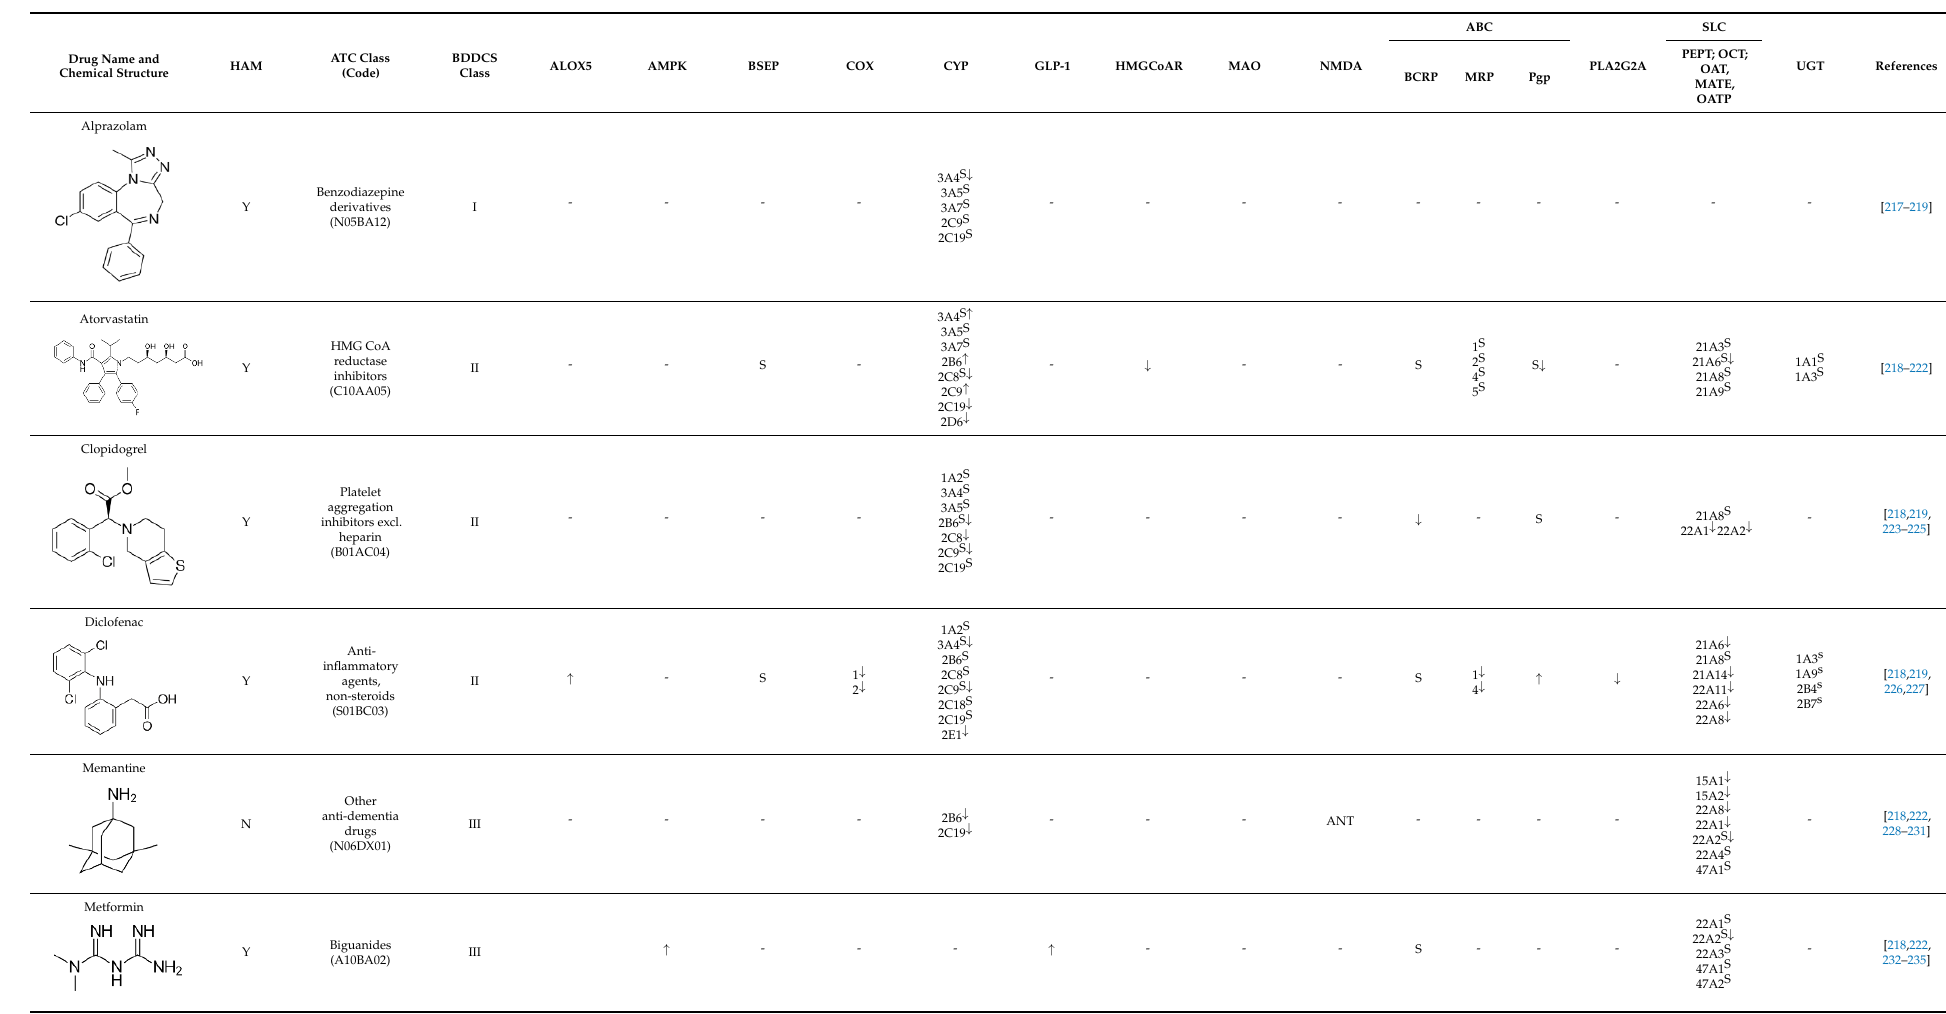
Table 2. Characteristics of the drugs used in the study. The main enzymatic targets (substrates, inhibitors, and inducers) are specified.